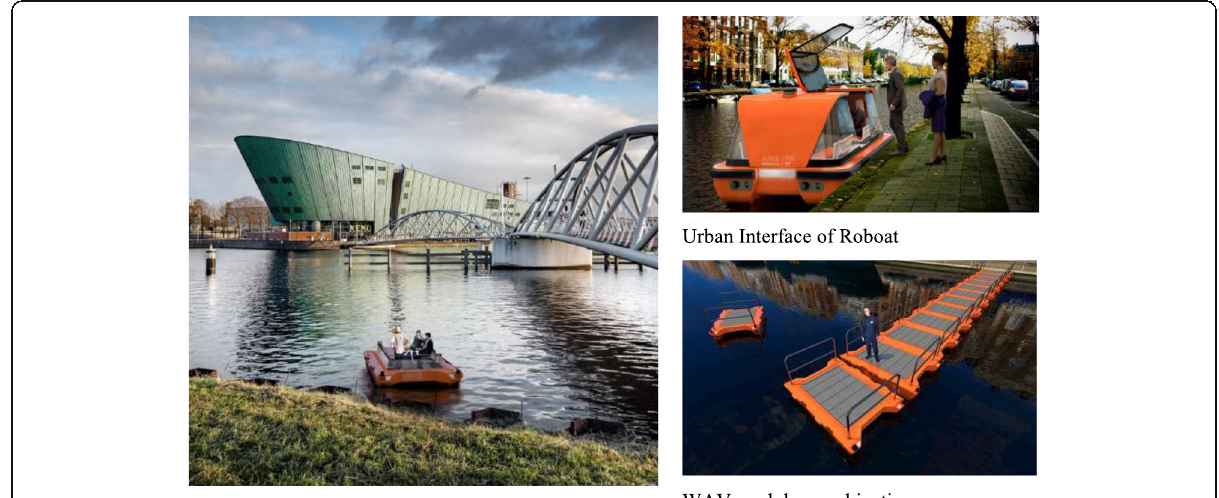
Fig. 1 Proposed design of WAVs (Senseable City Laboratory,